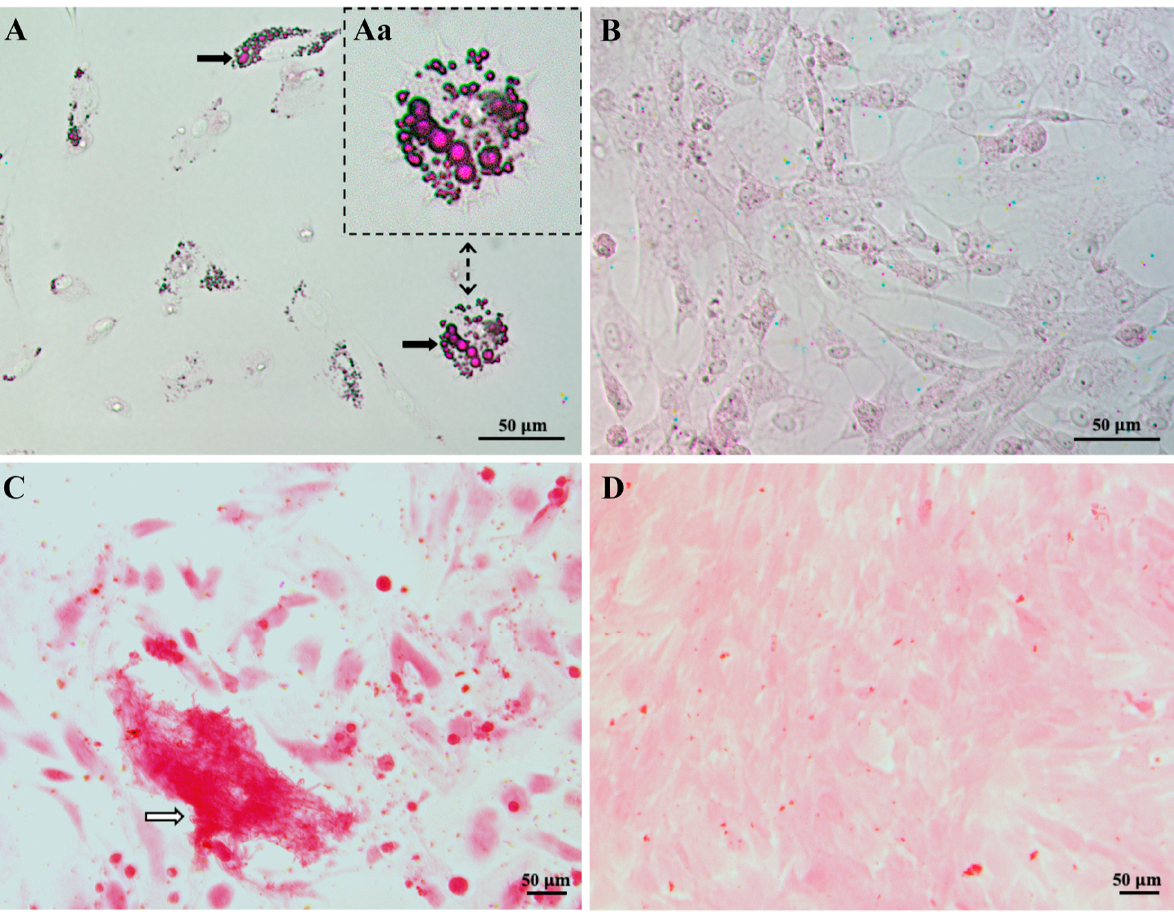
Figure 2. Differentiation of cultured mesenchymal stem cells (MSCs). All images are brightfield. In ( A ) MSCs that had differentiated into adipocytes after incubation in specific adipocyte differentiation media for 16/17 days are shown. Black arrows indicate red lipid droplets stained by an Oil Red O solution. ( Aa ) is a magnified area of ( A ) displaying differentiated adipocytes. In ( B ) MSCs that were maintained in normal growth media as a control for ( A ) showed no stained lipid droplets. In ( C ) MSCs that had differentiated into osteocytes after incubation in specific osteocyte differentiation media for 21 days are shown. A calcium deposit is indicated by a white arrow. In ( D ) MSCs at culture passage 12 are shown. These cells were maintained in the growth media as a control for ( C ). Note that the small red dots are floating precipitates of the stain and not stained cells. Since the cultured MSCs were derived from adipose tissue, and could differentiate into adipocytes or osteocytes, they specifically were adipose-derived (AD)-MSCs.